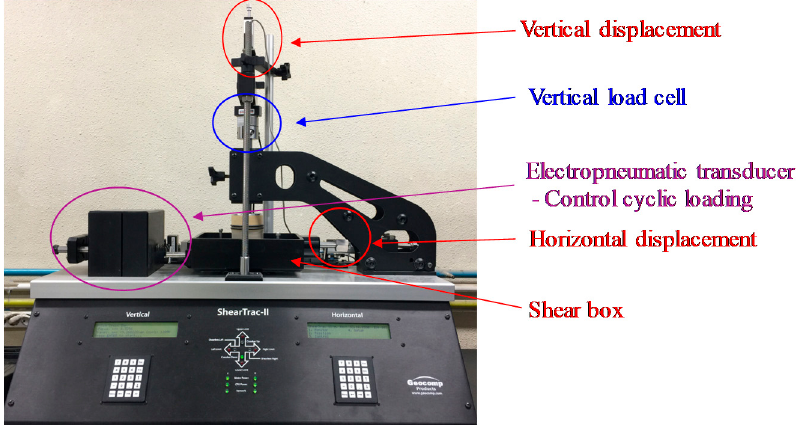
Figure 3. Cyclic simple shear device used in this study.